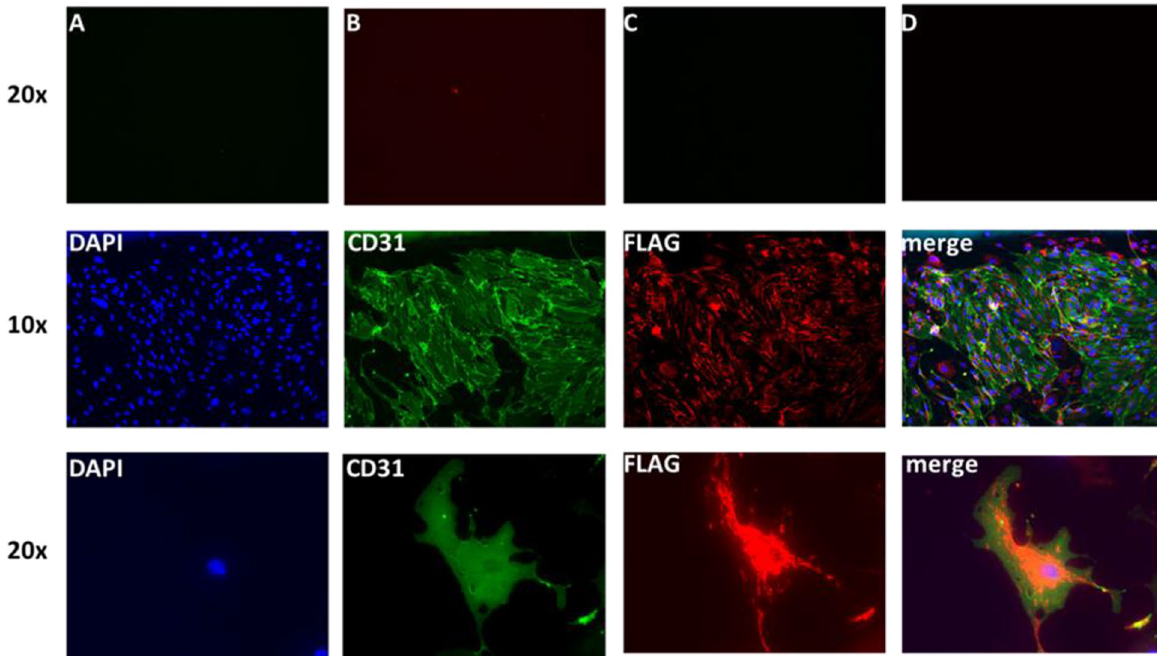
Figure 4. Immunofluorescence staining of aortic endothelial cells isolated from aorta of AGXT2 TG mice, showing the expression of transgene in endothelial cells (CD31 positive). First row: ( A ) CD31 negative control in green channel, ( B ) CD31 negative control in red channel, ( C ) FLAG negative control in green channel, ( D ) FLAG negative control in red